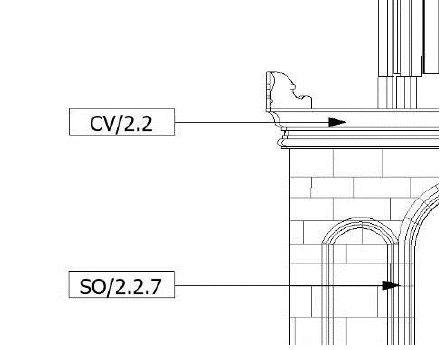
Figure 13. Building techniques identification